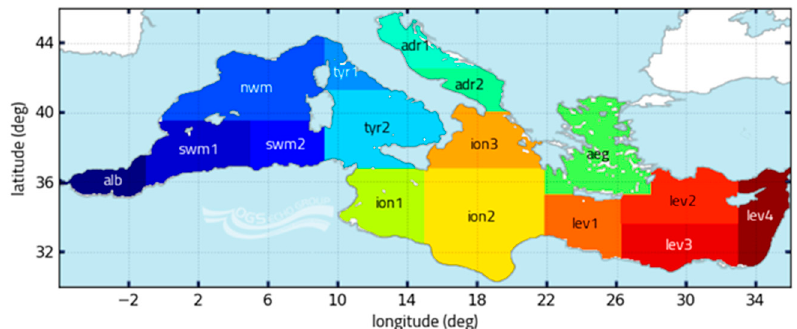
Figure 4. Basin subdivision in use in the CMEMS Mediterranean Sea validation procedure. The sub-basins considered are Alboran Sea (alb), south western Mediterranean (swm1 and swm2), north western Mediterranean (nwm), Tyrrhenian Sea (tyr1 and tyr2), Ionian Sea (ion1, ion2, and ion3), Adriatic Sea (adr1 and adr2), Aegean Sea (aeg), and Levantine Sea (lev1, lev2, lev3, and lev4).